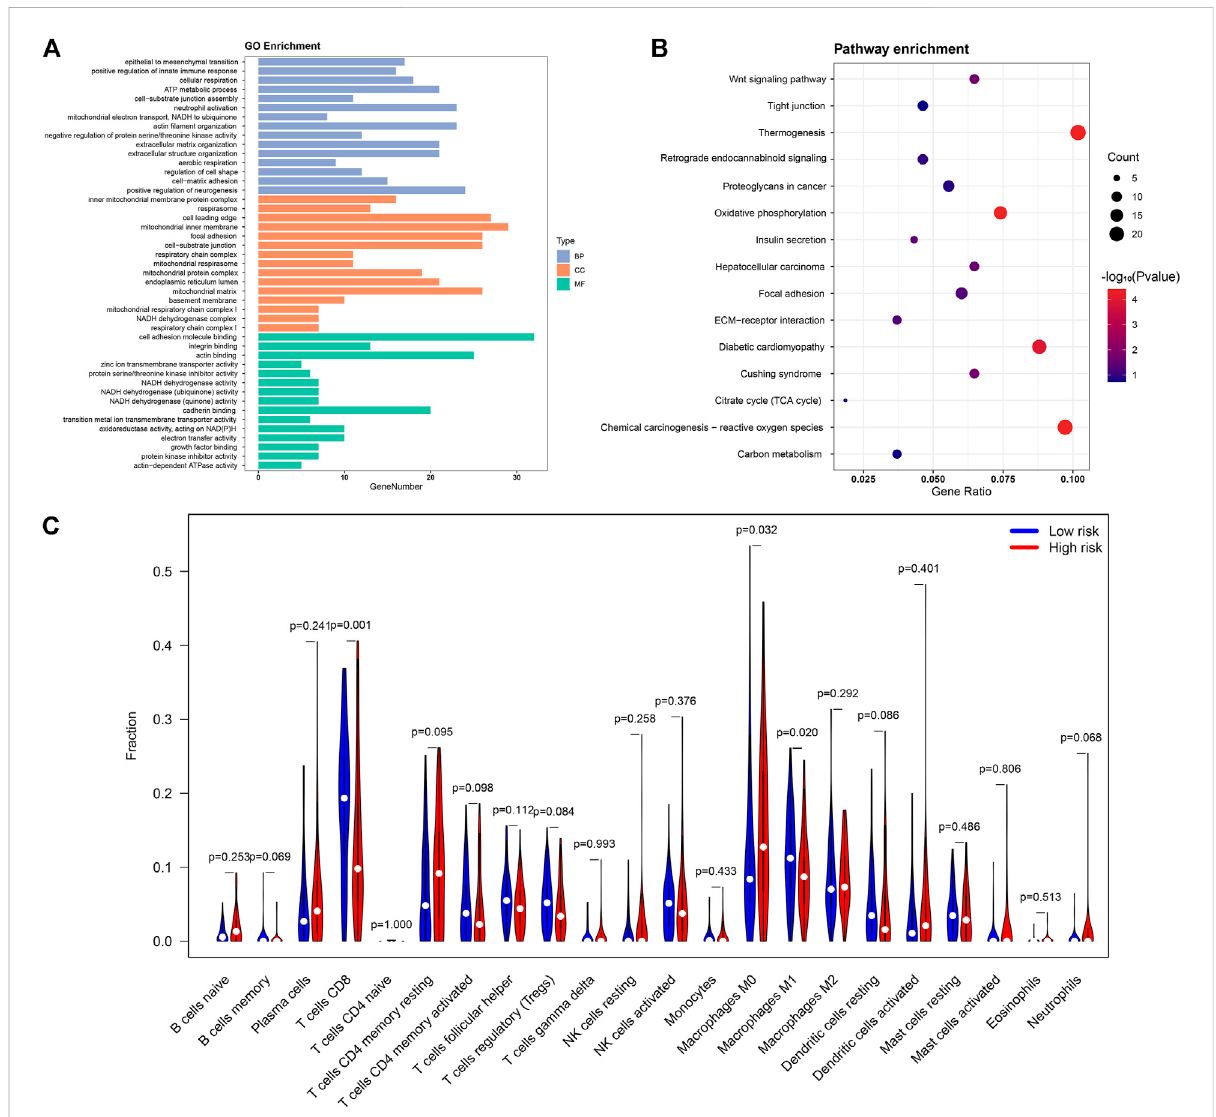
FIGURE 7 The potential role of lipid metabolism in CC and differences in immune cell in fi ltration. The functional analyses of lipid metabolism-related mRNAs using GO (A) and KEGG pathway analysis (B) ; (C) The violin map showing differences in immune cell in fi ltration between low- and high-risk